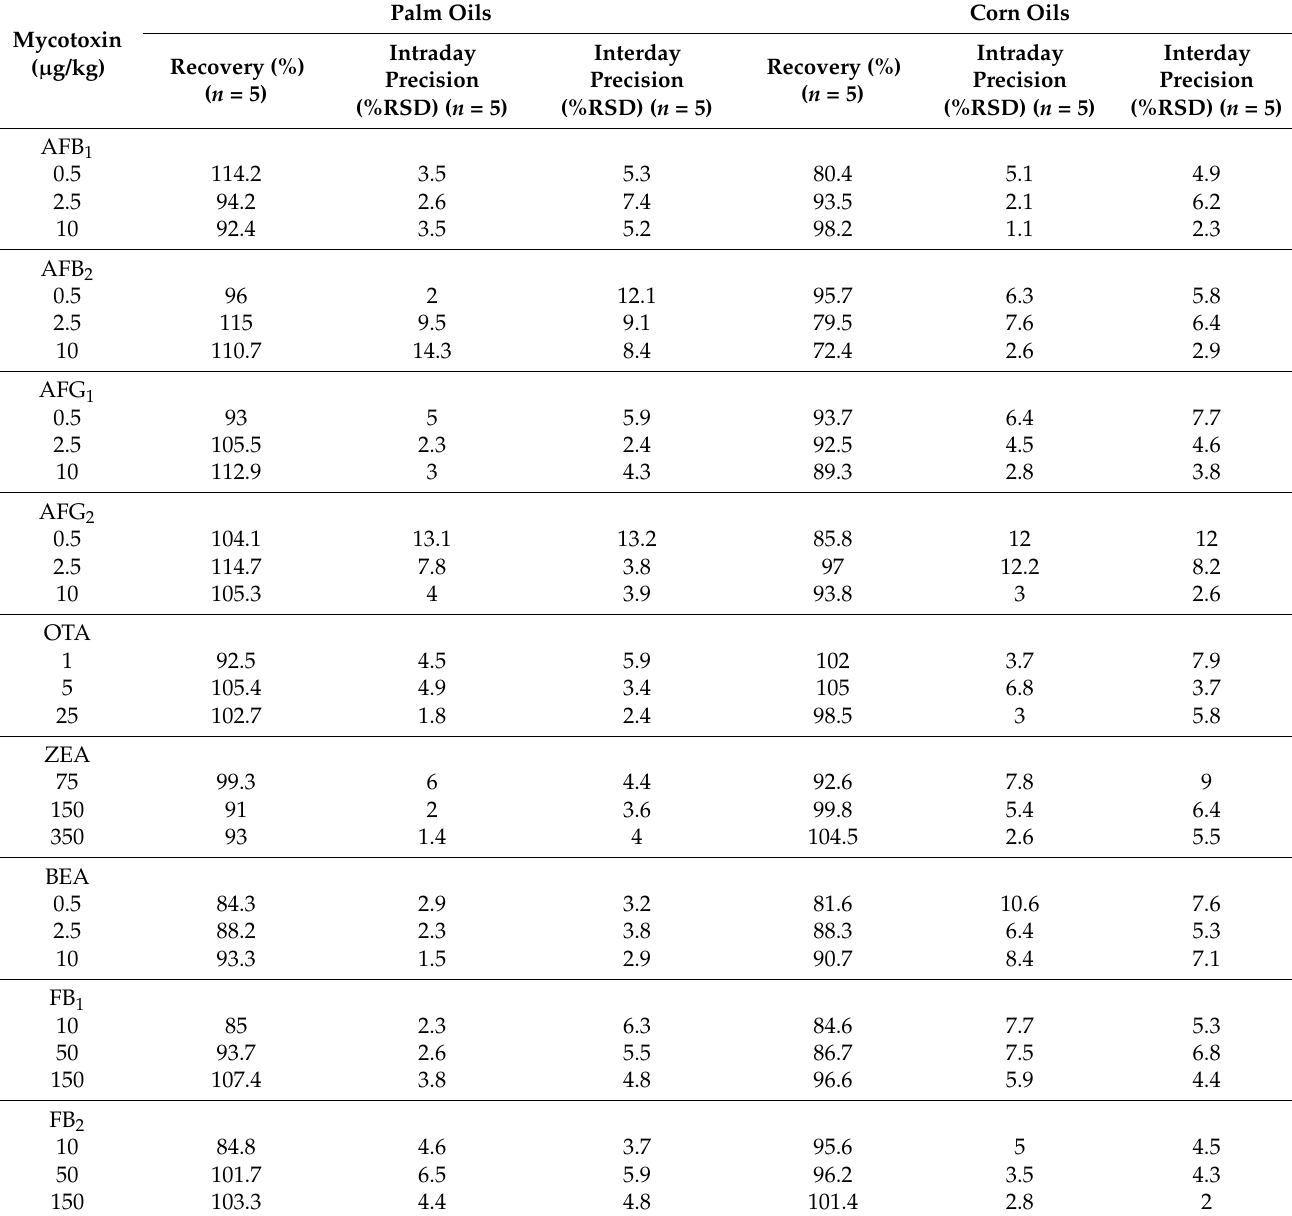
Table 3. Accuracy and precision for nine mycotoxins determined using optimal LC–MS/MS conditions for six different vegetable oil